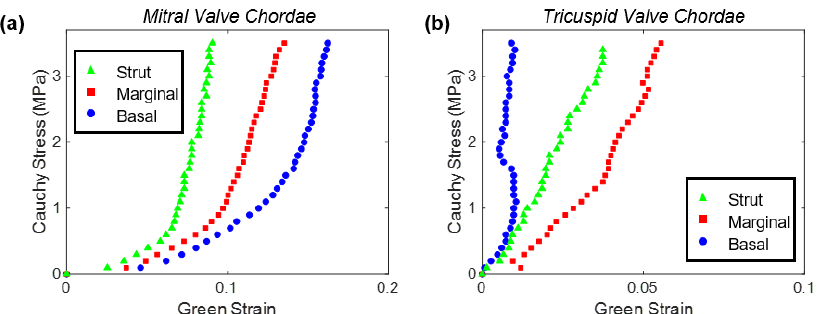
Figure 5. Results from the uniaxial mechanical testing of the strut, marginal, and basal chordae tendineae from: ( a ) the mitral valve anterior leaflet, and ( b ) the tricuspid valve anterior leaflet. (Plots reformatted from the data reported in Pokutta-Paskaleva et al. [55]).